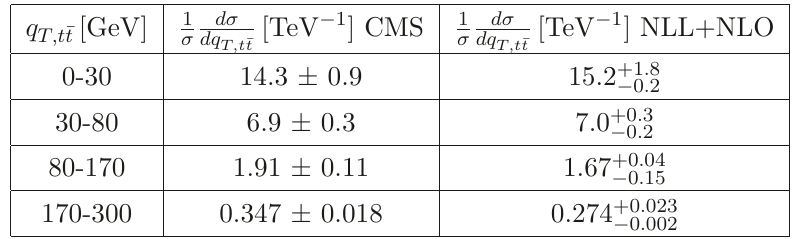
Table 3. The normalized q T distribution 1 /σ ( dσ/dq T ) of t ¯ t pairs in pp collisions at the LHC ( √ s = 8 TeV): comparison between CMS data (dilepton channels) [18] and NLL+NLO results. one-loop soft anomalous dimension of ref. [38]). We note, however, that the regular compo- nent dσ (reg) (see eq. (2.2)) of the NLL+NLO calculation is left unchanged, so as not to